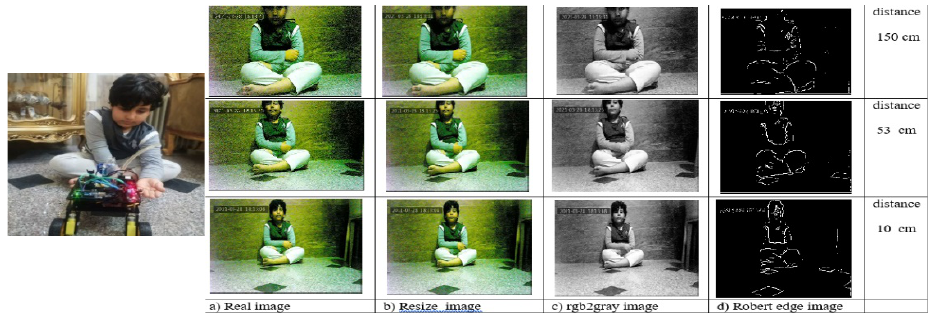
Fig. 5. Image processing of child that captured from mobile robot camera .